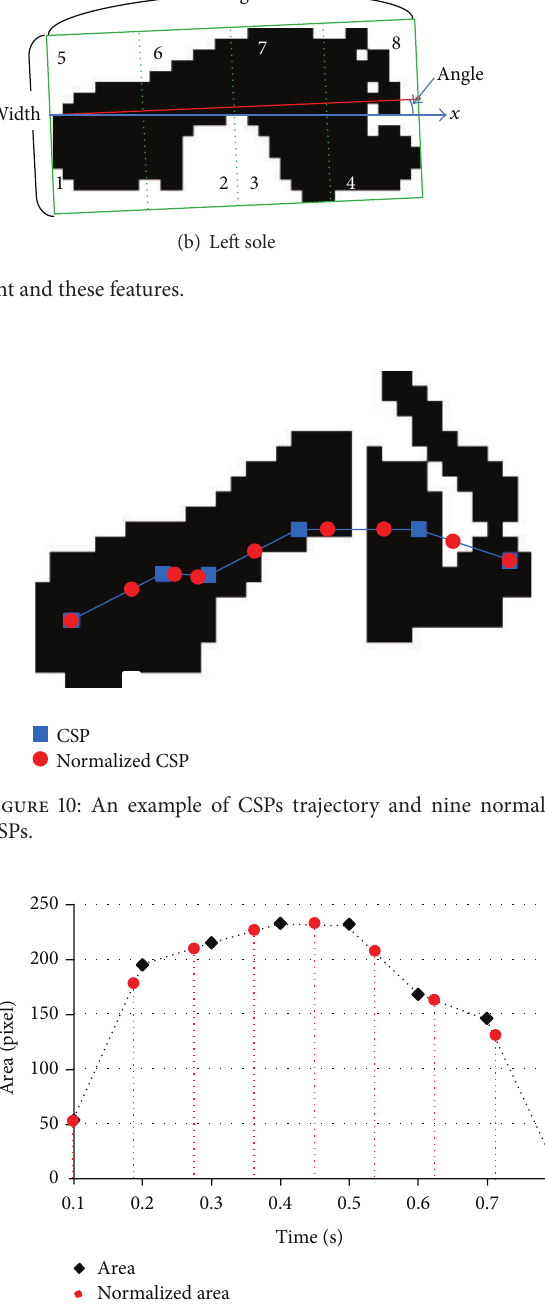
the classification score 𝛽 𝑟 𝑘,𝑖 from all domains. The system employs these parameters 𝛼 𝑟 𝑘,𝑖 , 𝑡 𝑟 𝑘,𝑖 , and 𝑢 𝑟 𝑘,𝑖 with the highest 𝛽 𝑟 𝑘,𝑖 among all domains for a feature The determination process are repeated for all 𝑘 and 𝑖 of 𝑦 𝑟